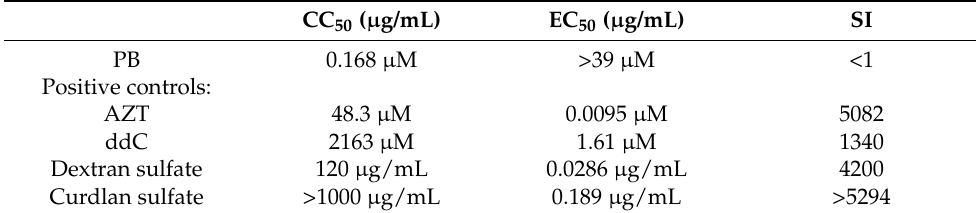
Table 3. Quantification of anti-HIV activity of pyoktanin.